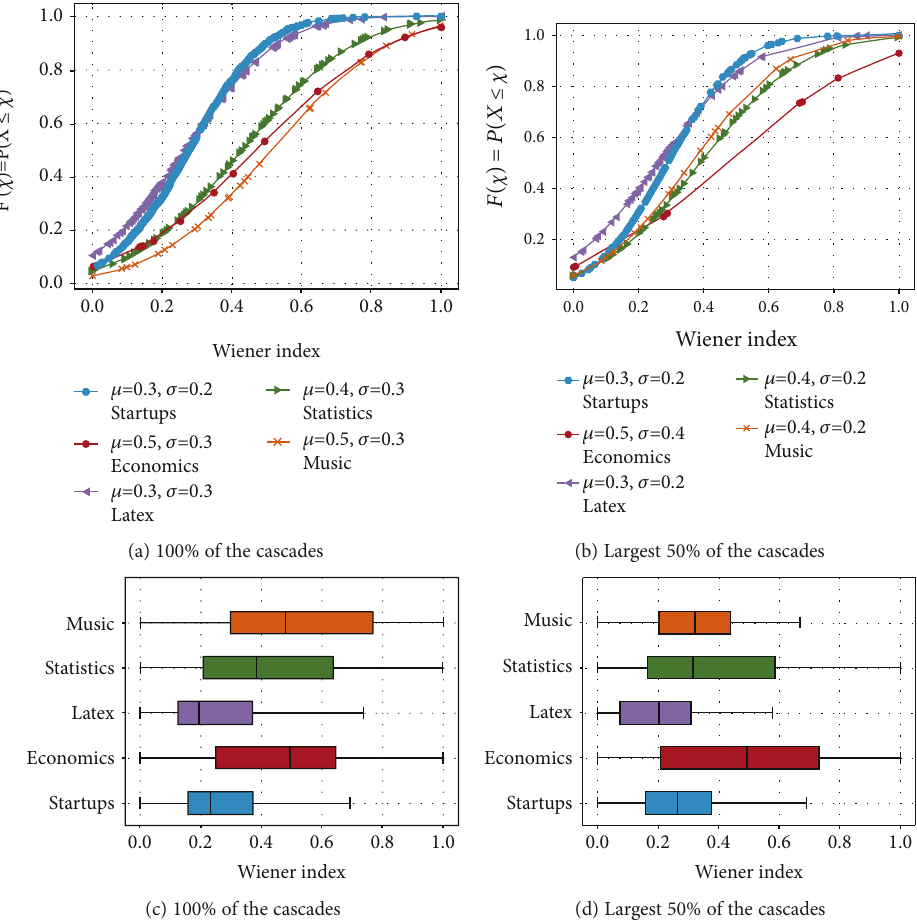
Figure 3: The fi gure shows the Wiener index of the observed cascades as CDF (a and b) and as box plots (c and